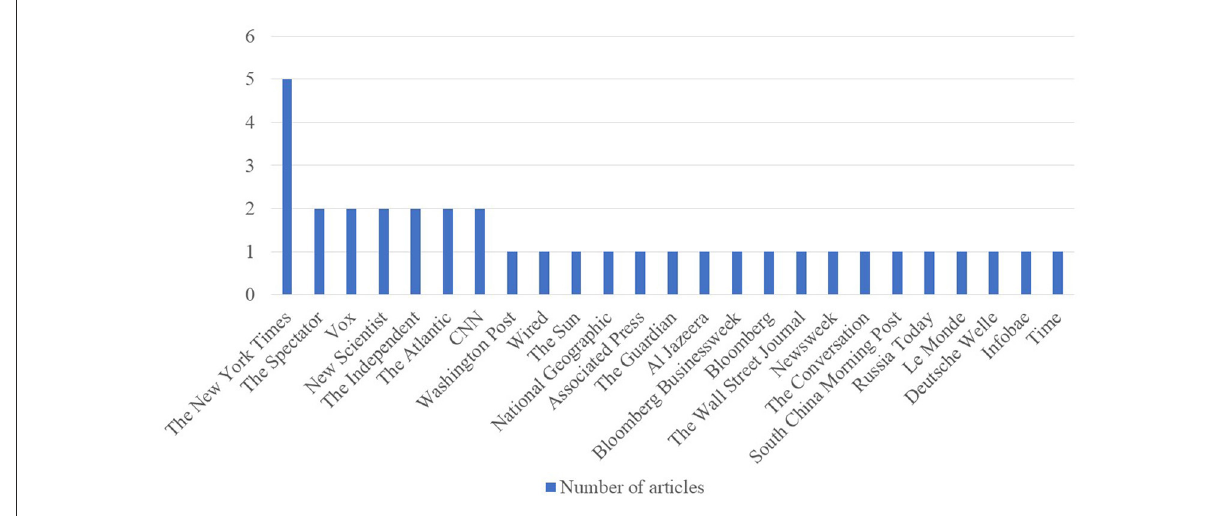
FIGURE1 Sources of articles.